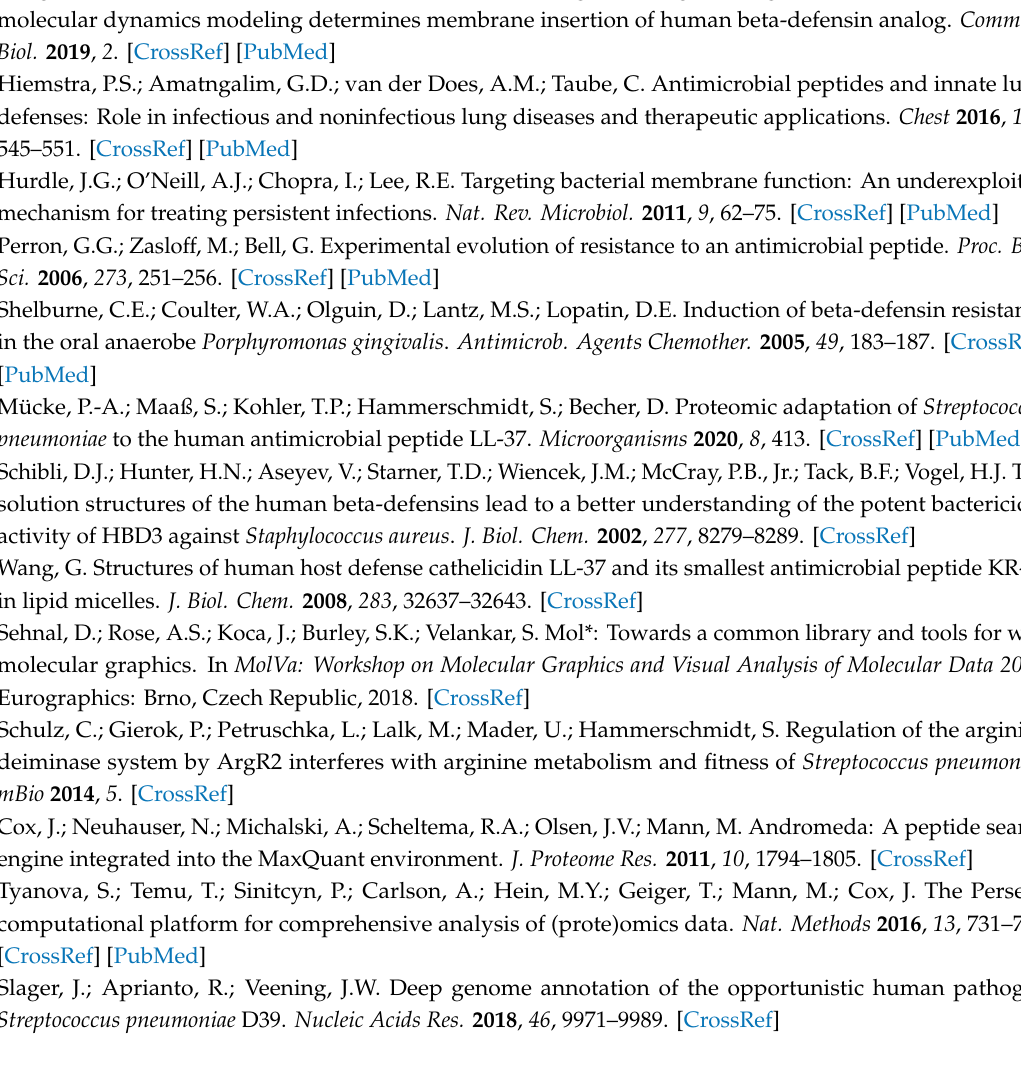
Figure S1: Scatter plots of hBD3 samples; Figure S2: Scatter plots of CTAB samples; Table S1: Significant changes in protein abundance of S. pneumoniae D39 upon CTAB exposure; Table S2: Changes in protein abundance of S. pneumoniae D39 upon hBD3, LL-37, or CTAB exposure,